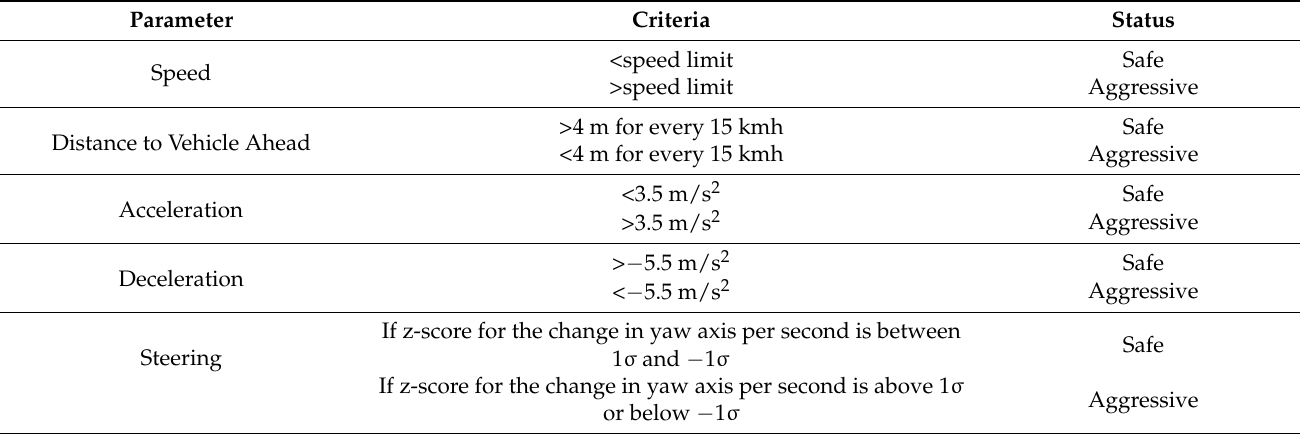
Table 3. Criteria for safe and aggressive